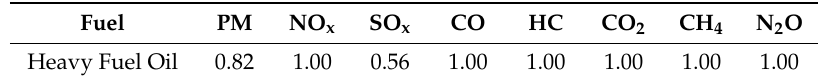
Table 5. Fuel correction factors